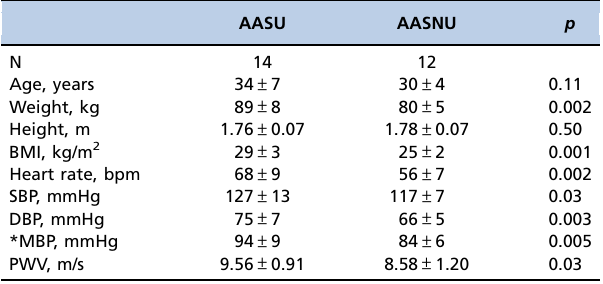
Table 1 - Physical characteristics, heart rate, blood pressure, and pulse wave velocity in anabolic androgenic steroid users and anabolic androgenic steroid